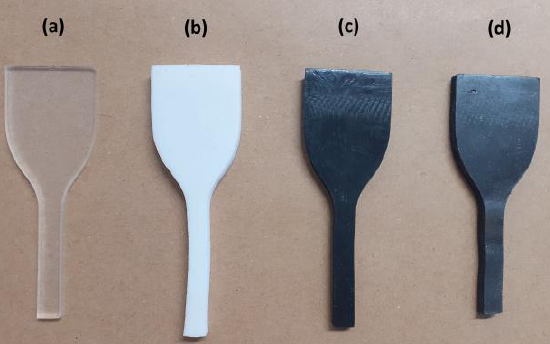
Figure 3. Post-test dumbbell samples: ( a ) neat PDMS; ( b ) hBN (40%)/PDMS; ( c ) GNP (8%)/PDMS; ( d ) hBN (40%)/GNP (10%)/PDMS. ( d ) hBN (40%)/GNP